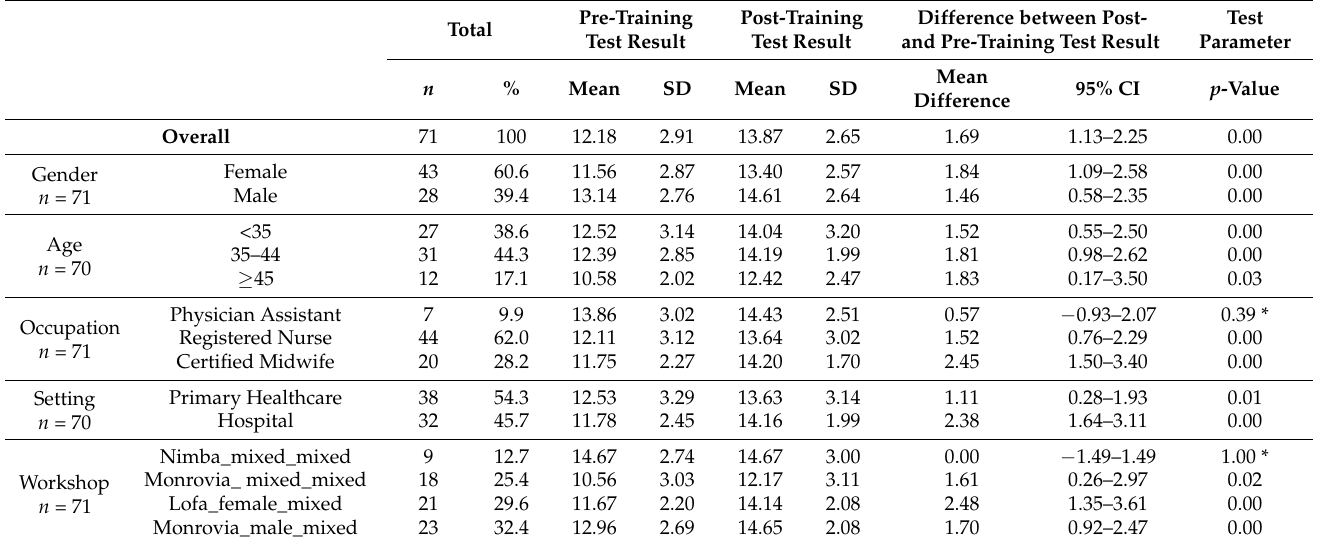
Table 5. Mean and mean difference of pre- and post-training results stratified by socio-demographics. Pre-Training Post-Training Difference between Post- Total Test Result Test Result and Pre-Training Test